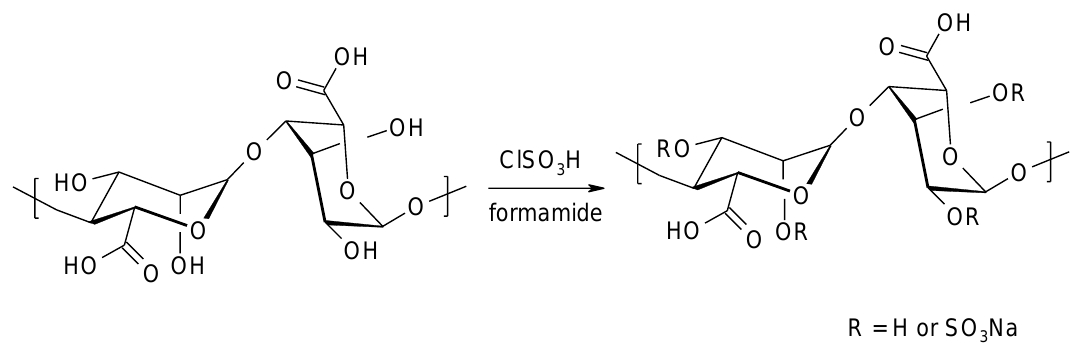
Figure 8. Preparation of sulphate alginate derivatives using chlorosulfonic acid. Cohen et al. proposed a method of obtaining alginate sulphates using carbodiimide coupling reagents [57]. The hydroxyl groups were esterified with the DCC–sulfuric acid derivative generated in situ. No activation of alginate carboxyl groups was observed (Figure 9).